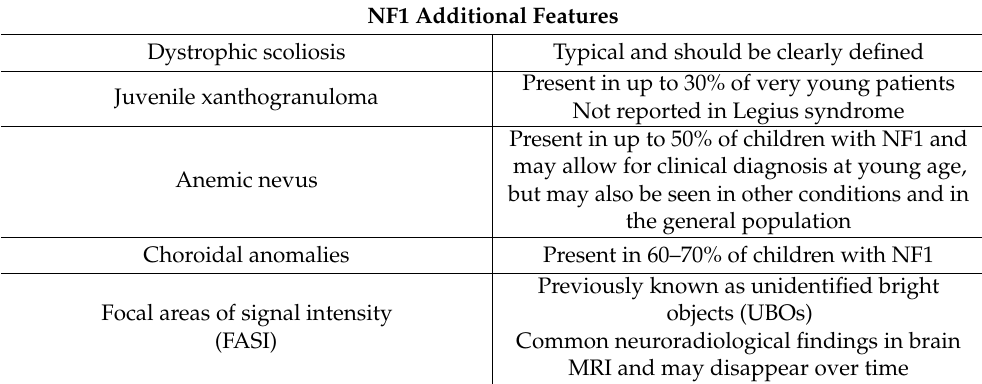
Table 2. Typical additional characteristics of NF1 according to Bergqvist et al.